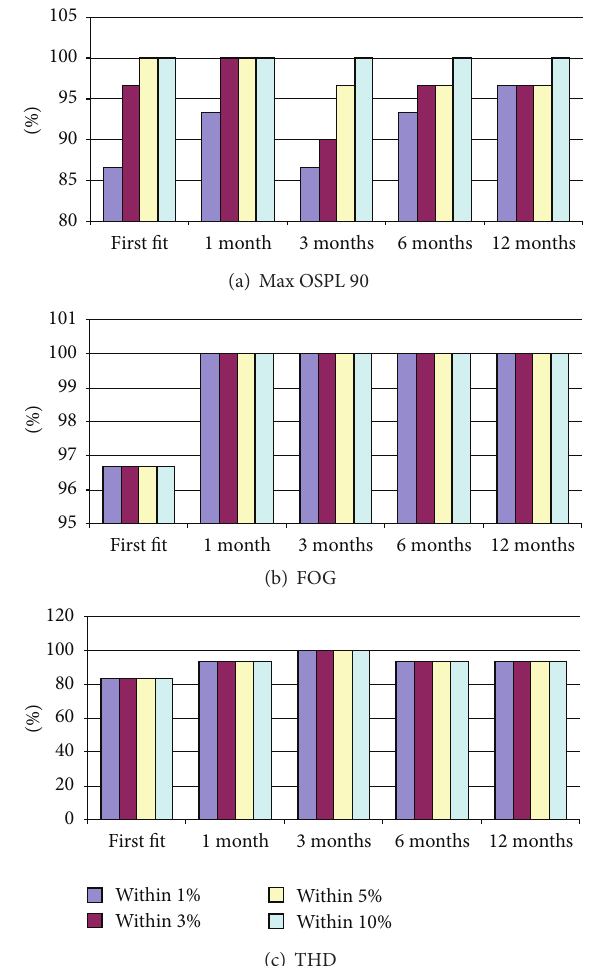
Figure 6: Consistency test results